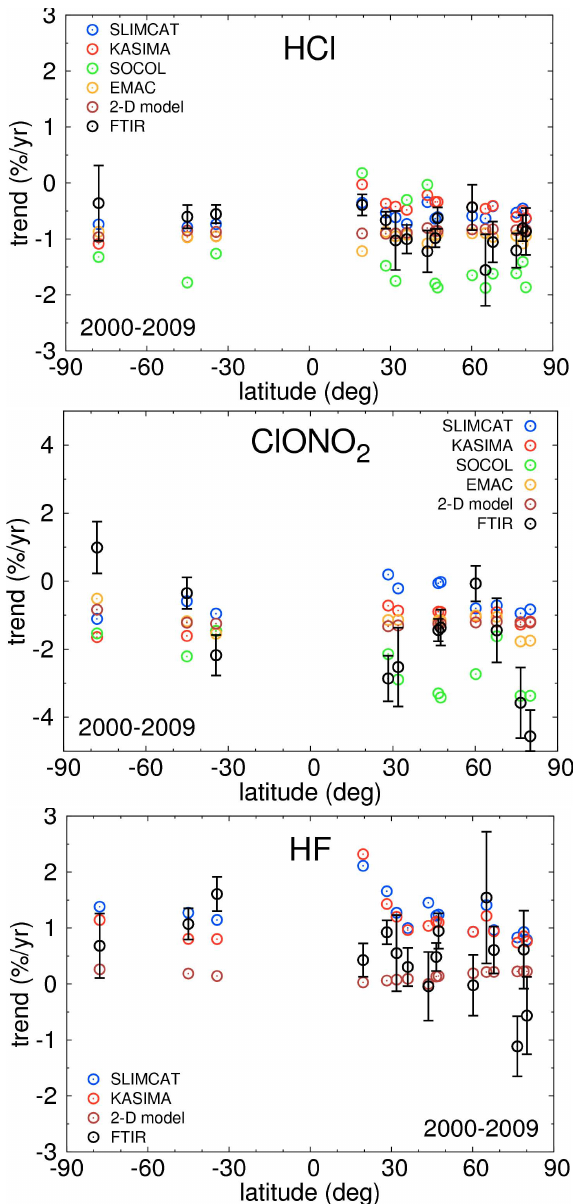
Fig. 12. Comparison of the trends from the FTIR measurements (black) between 2000 and 2009 (in% per year) with those modelled by SLIMCAT (blue), KASIMA (red), SOCOL (green), EMAC (or- ange), and the Bremen 2-D model (brown) for HCl, ClONO 2 , and HF. In order not to overload the picture, the bootstrap error bars for the modelled trends are not shown, only those for the measure- ments. Concerning the reasons for missing trend values please see